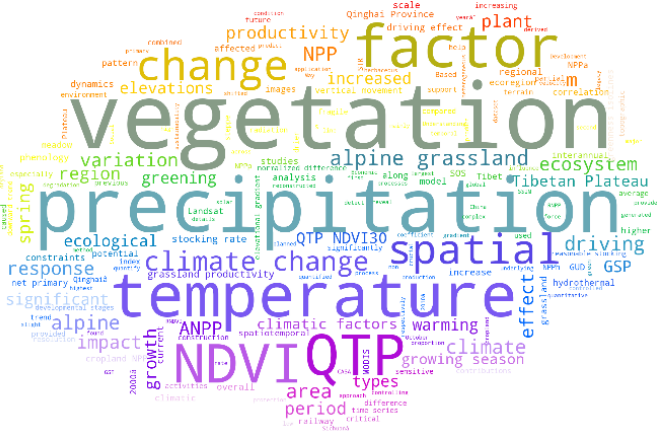
Figure 1. Word cloud showing the word occurrence frequency in the abstracts of the published pa- pers in this Special Issue. Larger words indicate a higher occurrence frequency. papers in this Special Issue. Larger words indicate a higher occurrence